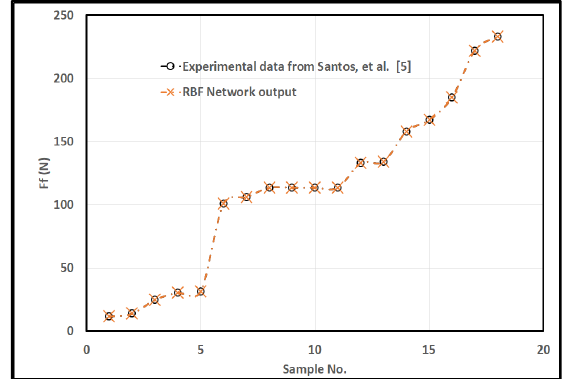
Fig. 5 The neural network for the experimental data from Santos, et al. [5] .